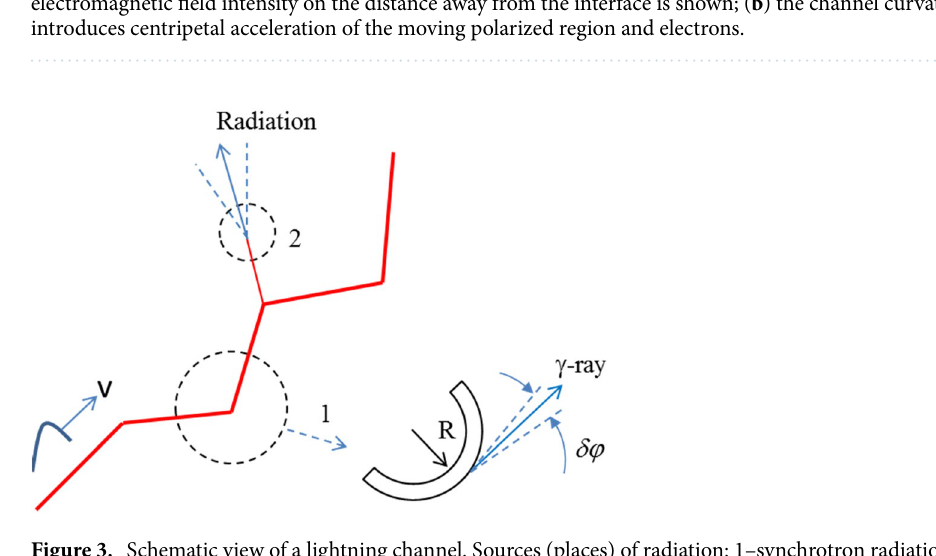
Figure 3. Schematic view of a lightning channel. Sources (places) of radiation: 1–synchrotron radiation; 2– transition